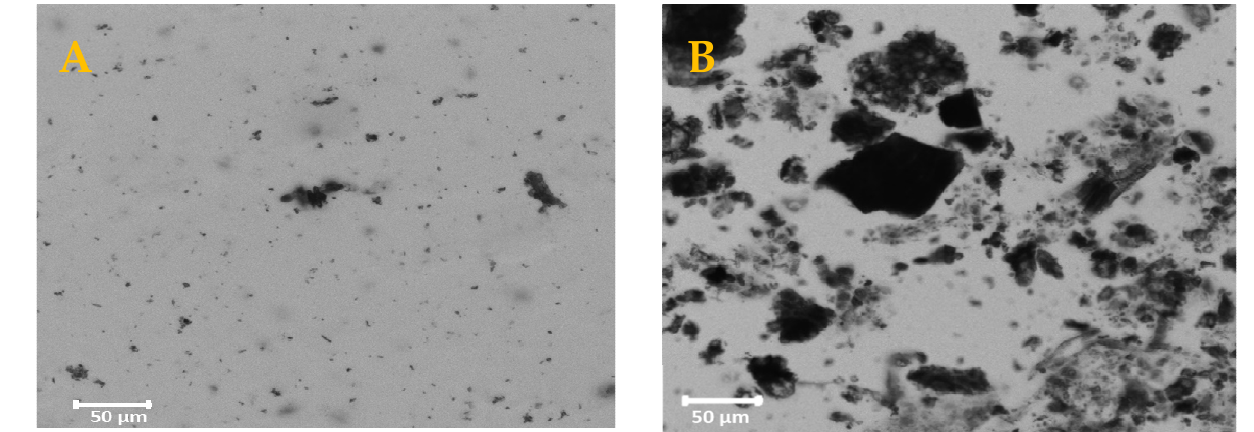
Figure 2. Confocal microscopy images of centrifuged ( A ) and non-centrifuged ( B ) media employed as fermentation broths (×20 magnification).